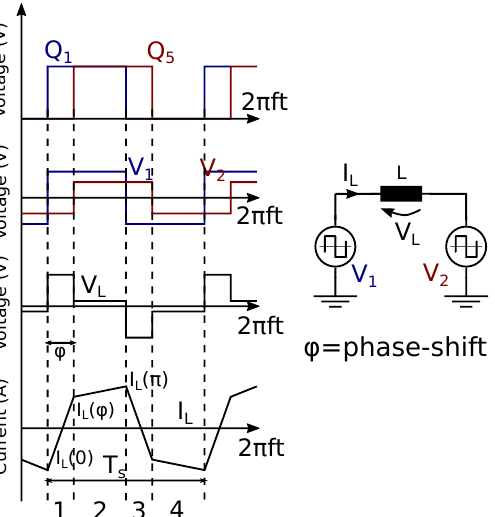
Figure 2. DAB waveforms, from top to bottom: the gate signals of Q1 and Q5, primary and secondary voltages, inductor voltage and current VL,